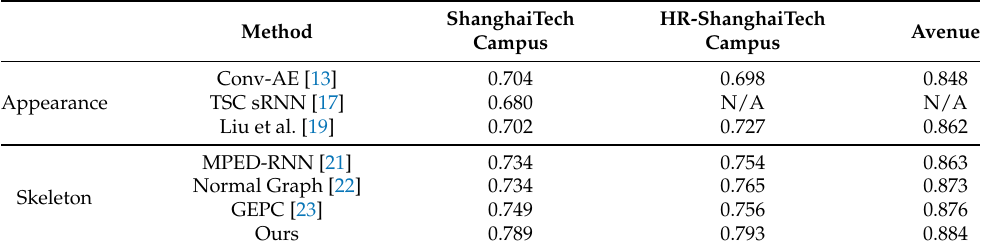
Table 1. Anomaly Detection Results. The performance of different methods on ShanghaiTech Campus Dataset, Human-Related ShanghaiTech Campus Dataset (HR-ShanghaiTech) and CUHK Avenue (Avenue). The results are frame-level AUC